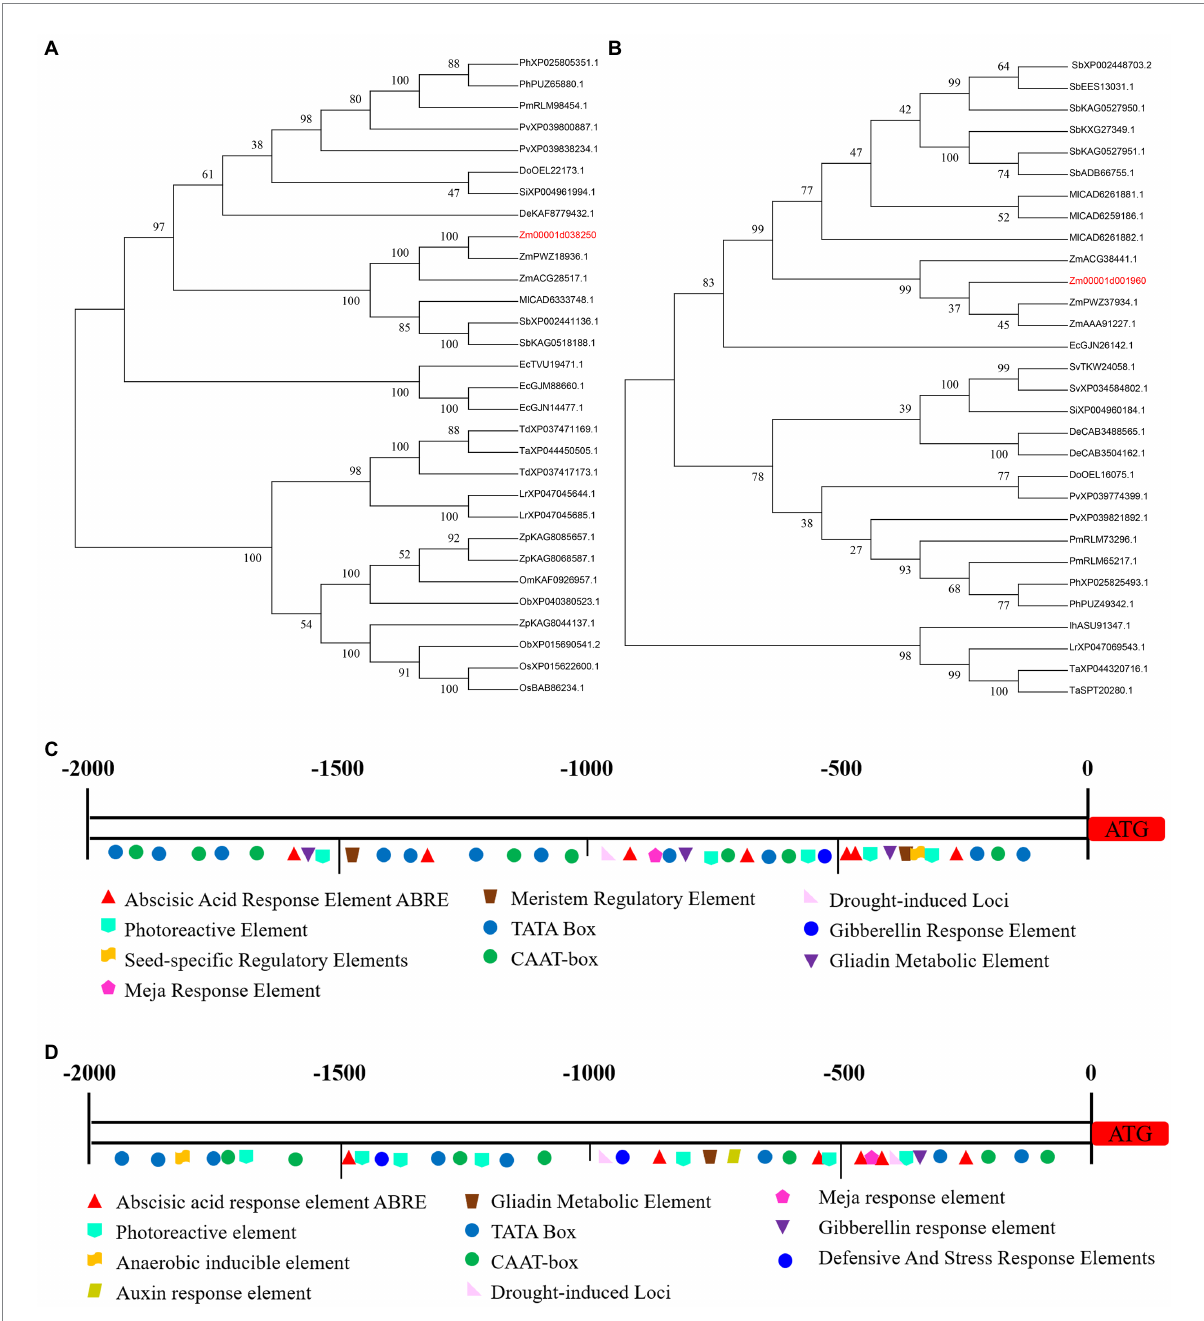
FIGURE 7 The characterization of candidate genes. (A) Evolutionary tree of Zm00001d038250 protein. (B) Evolutionary tree of Zm00001d001960 protein. (C) The promoter region of Zm00001d038250 gene. (D) The promoter region of Zm00001d001960